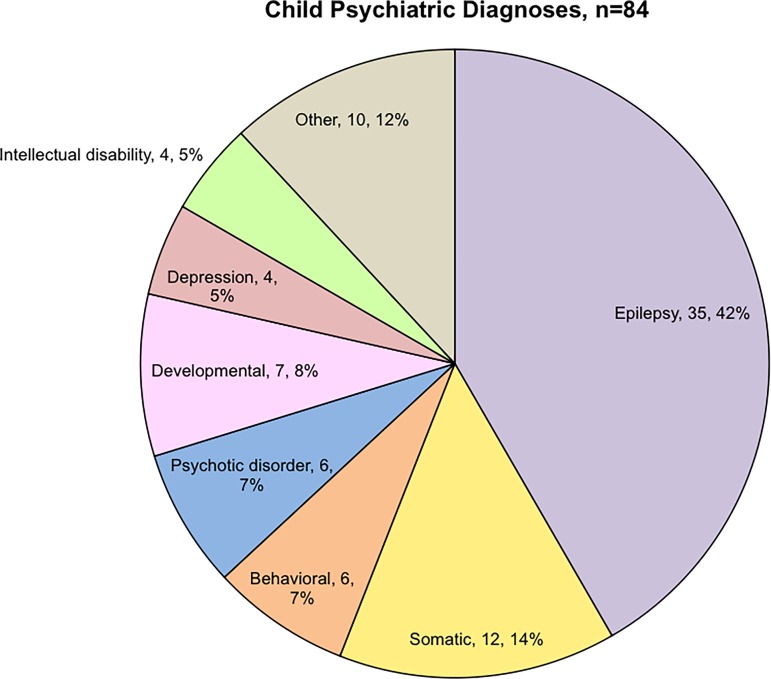
Child diagnoses (n, %).